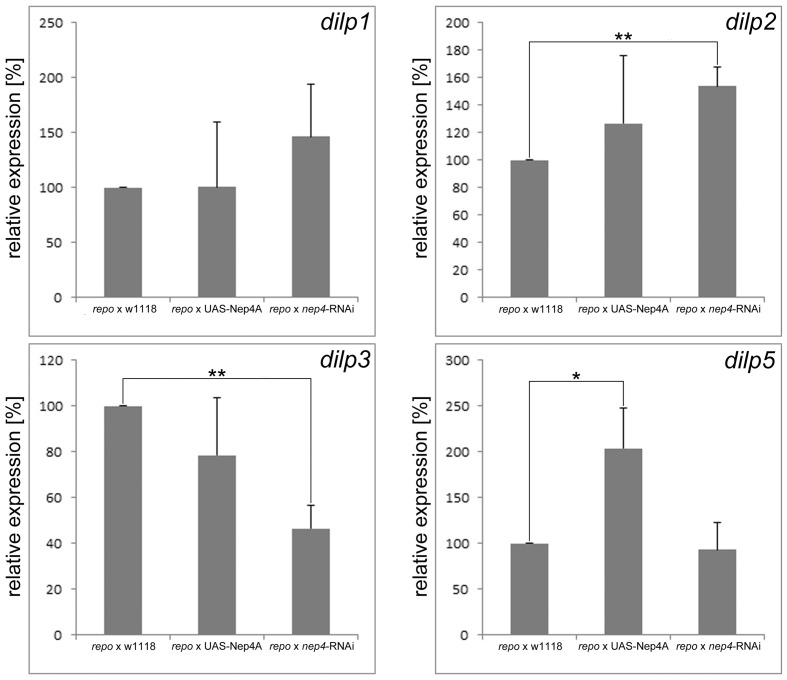
Glial cell-specific modulation of nep4 expression affects dilp expression in transgenic third instar larvae.Changes in the expression of dilp genes are depicted as percentages (%) relative to the expression in control specimens (repo-Gal4 x w1118), which was set to 100%. Glial cell-specific overexpression of Nep4A (repo-Gal4 x UAS-Nep4A) increased the expression of dilp5 by 104%, while nep4 knockdown in the same tissue (repo x nep4-RNAi) resulted in the upregulation of dilp2 by 54% and downregulation of dilp3 by 54%. Values represent the mean (+ s.d.) of at least three independent biological replicates, each consisting of at least three technical replicates. Asterisks indicate statistically significant differences (*p<0.1; **p<0.05, one-way ANOVA with pairwise comparisons).